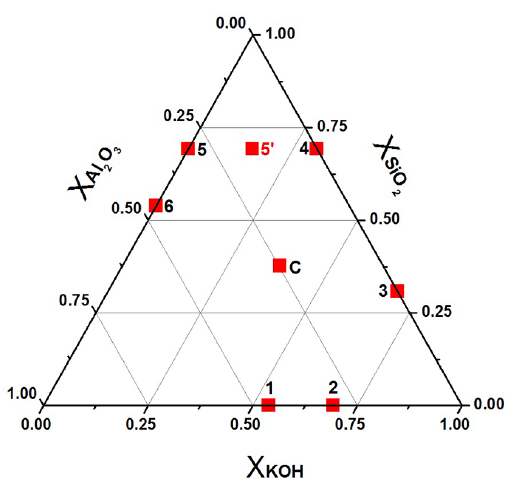
Figure 2. Three-component mixture design in terms of pseudo- components.